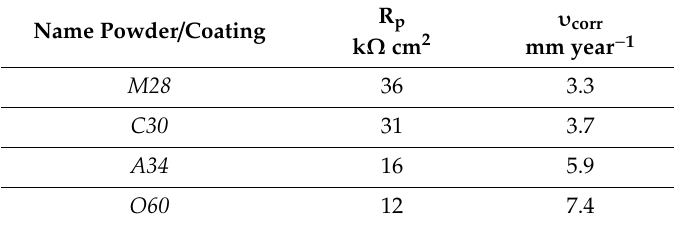
Table 3. Polarization resistance and corrosion rate of nickel coatings on the Al7075 substrate.